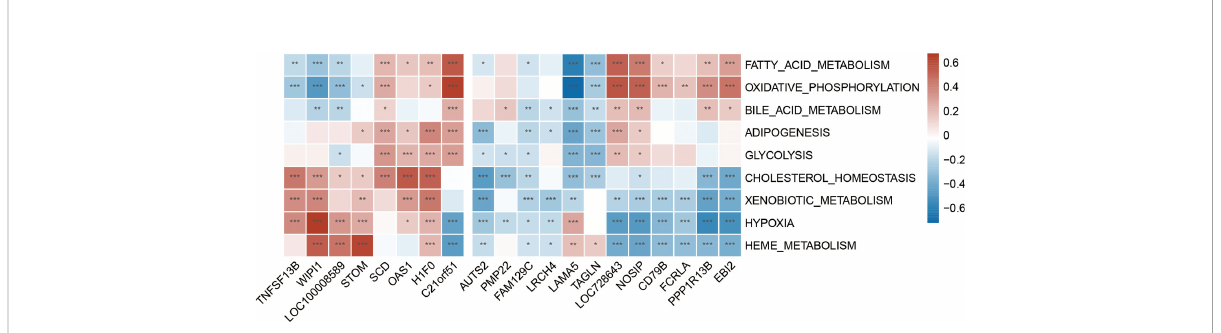
FIGURE 9 Correlation matrix between metabolic pathways and shared hub genes in SLE. The left part showed those up-regulated hub genes, and the right part showed the down-regulated hub genes. Red represents for positive correlation, while blue for negative correlation. Asterisks represent levels of signi fi cance (*p < 0.05, **p < 0.01, ***p <